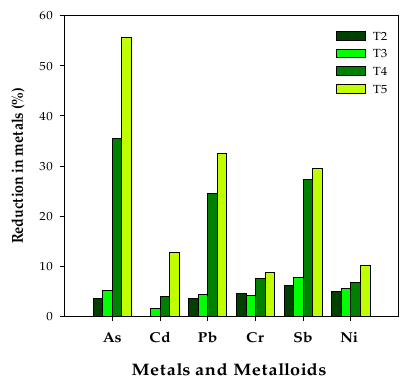
Figure 2. Reduction in metals during rice cooking in low- and high-water system.